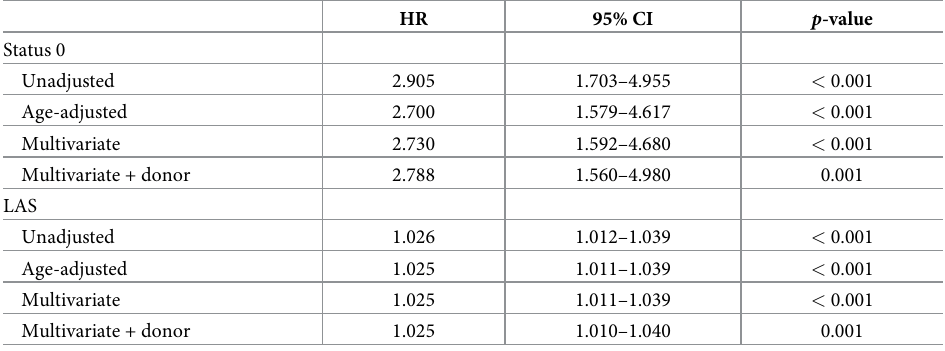
Table 3. Univariate and multivariate hazard ratios of death based on Korean urgency status and the lung alloca- tion score. HR 95% CI p